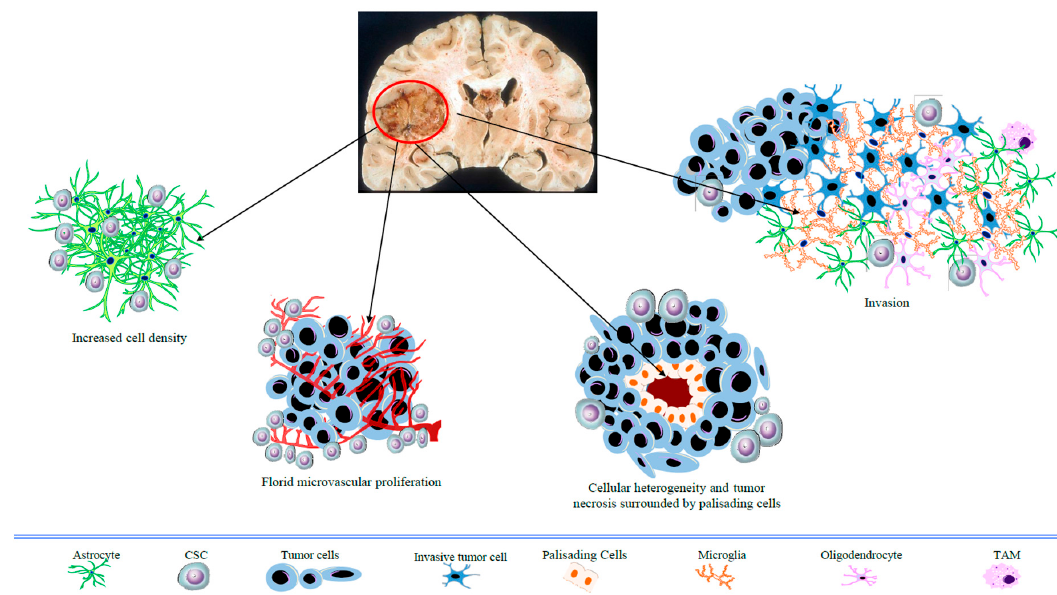
Figure 1. Schematic overview of the histopathological hallmarks of glioblastoma (GBM). CSC: cancer stem cell; TAM: tumor-associated macrophage.